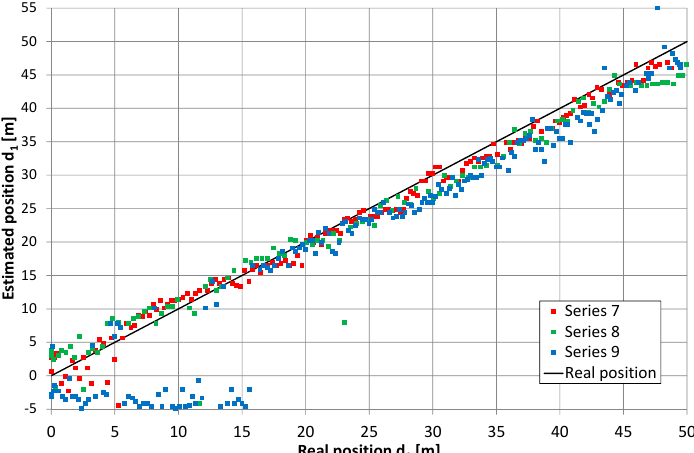
Figure 12. Results of position estimation in the case of return signal frequency conversion; the height of receiving antenna: 1 m, series 4–6.